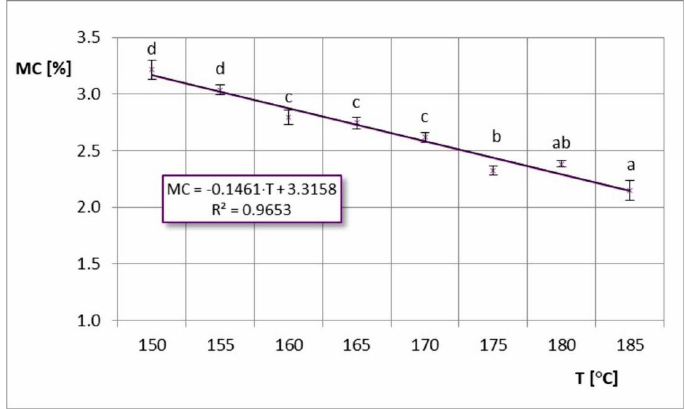
Figure 1. Moisture content (MC) in spray-dried chokeberry juice at different inlet air temperatures (T); (a, b, c, d — different letters show significant differences between mean values ( p ≤ 0.05)).